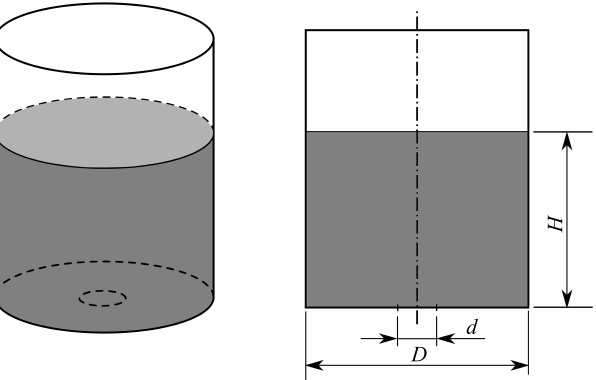
Figure 4. Scheme of the flat-bottomed silo: 3D view (left) and a vertical mid-plane (right).